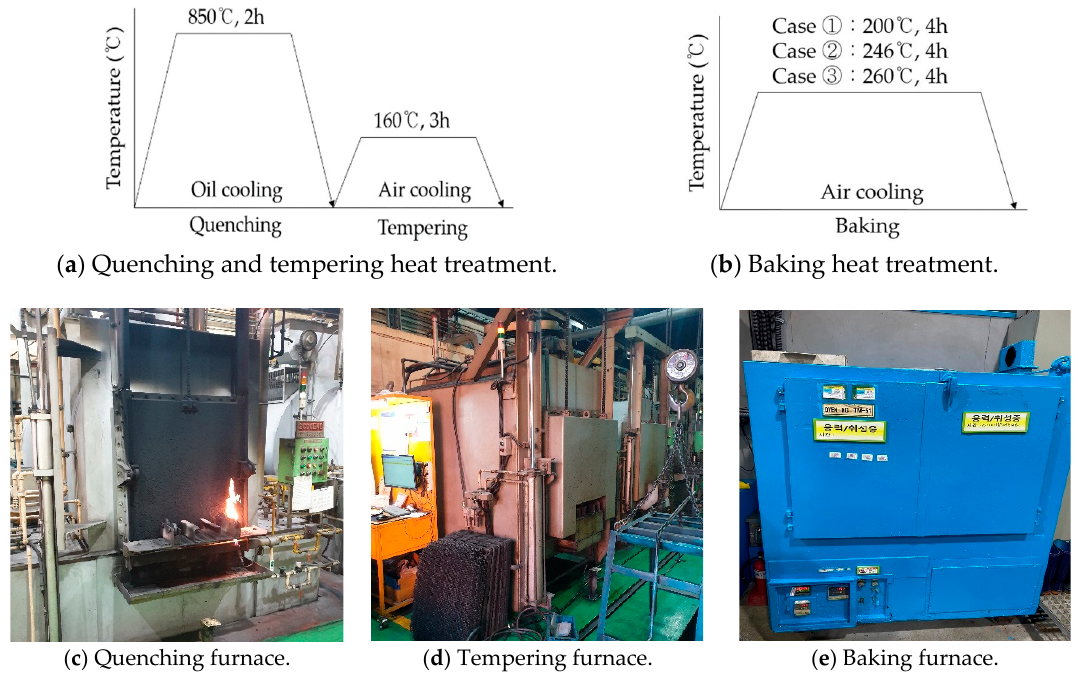
Table 2. Shot peening (SP)